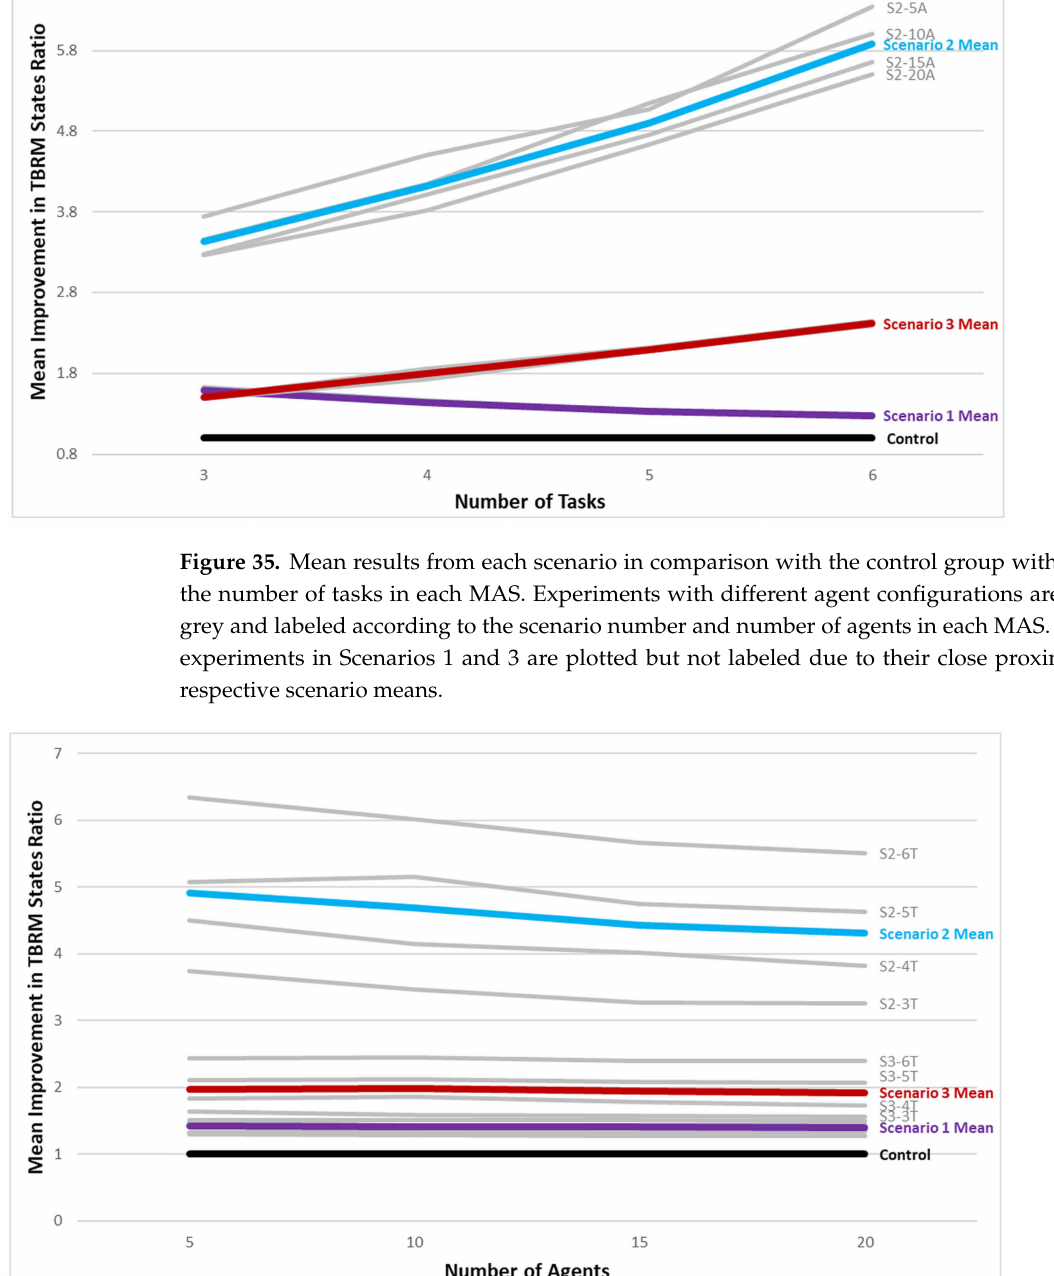
Figure 36. Mean results from each scenario in comparison with the control group with respect to the number of agents in each MAS. Experiments with different task configurations are shown in grey and labeled according to the scenario number and number of tasks in each MAS. Individual experiments in Scenario 1 are plotted but not labeled due to their close proximity to the scenario